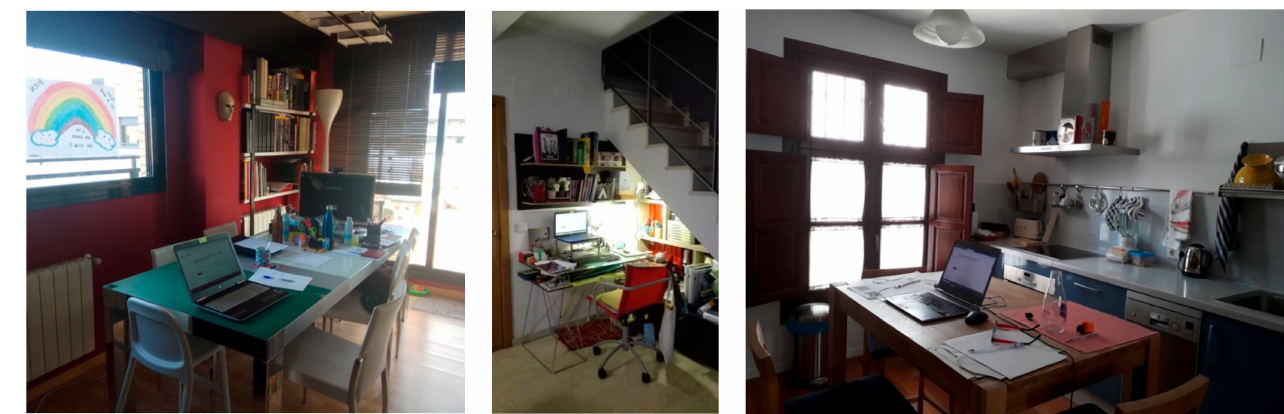
Figure 8. Photos taken by participants on telework spaces. Categories and subcategories extracted from the graphical information are in Table 5. Table 5. Categories and subcategories extracted after graphical analysis of